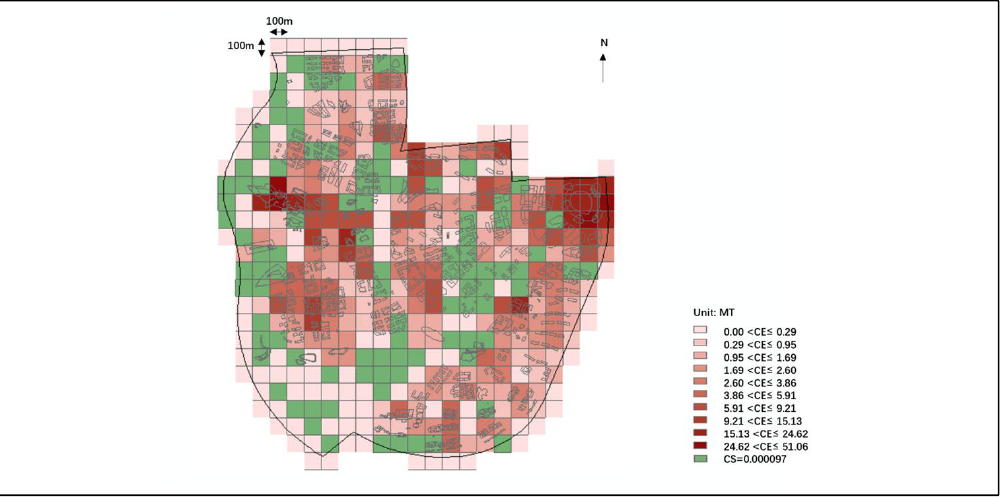
Figure 7. Carbon emission and carbon sink distribution of Lihu Future City design scheme in 100 × 100 m unit.